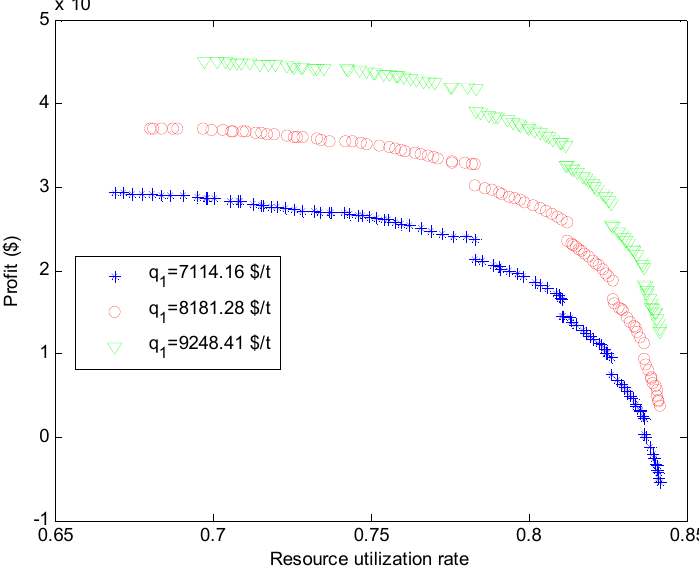
Figure 14. Sensitivity of the Pareto-optimal solutions to the unit copper concentrate price.